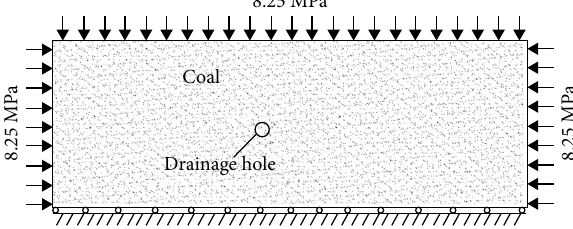
Figure 1: The calculation model.